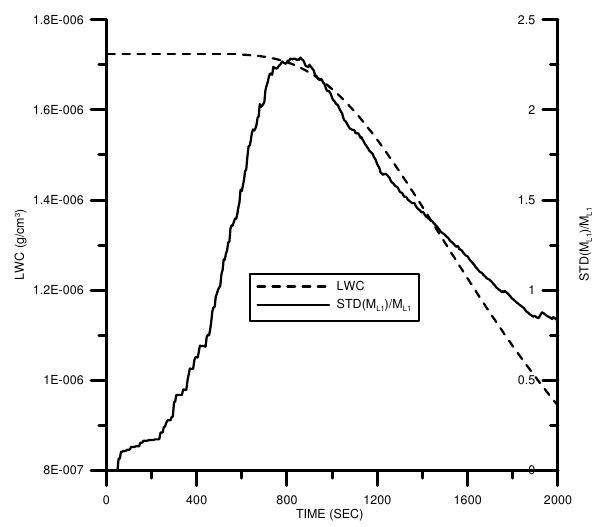
Fig. 6. Time evolution of total liquid water content calculated from Figure 6. Time evolution of total liquid water content calculated from the numerical the numerical solution of the KCE for the hydrodynamic kernel . M L 1 (solid line) esti- solution of the KCE for the hydrodynamic kernel (dashed line) and the statistics (dashed line) and the statistics STD (M L 1 ) mated from the Monte Carlo algorithm. The simulations were per- M (solid line) estimated from the Monte Carlo algorithm. The simulations formed for the hydrodynamic kernel with a bidisperse initial condi- were performed for the hydrodynamic kernel with a bidisperse initial condition tion N( 1 ; 0 ) = 50 and N( 2 ; 0 ) = 50 .